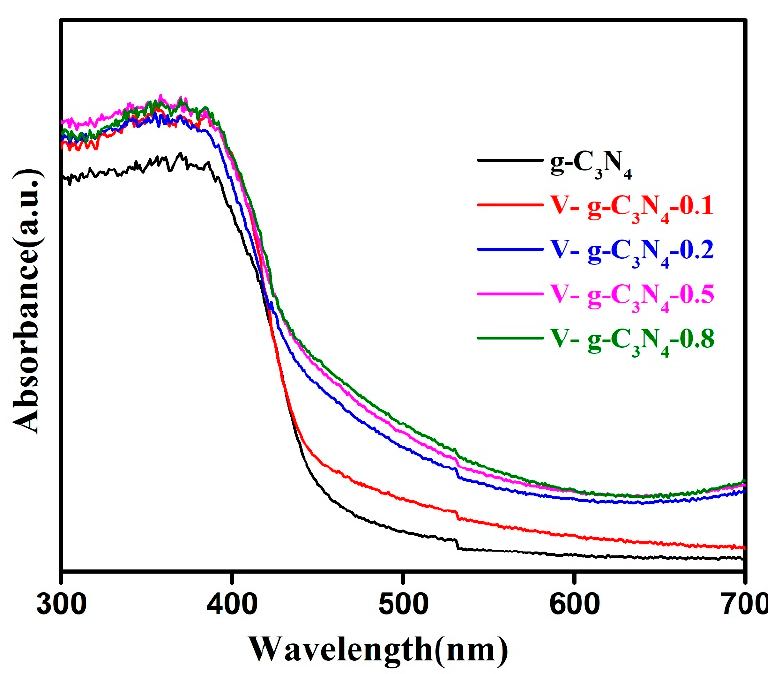
Figure 5. DRS spectra of the samples.